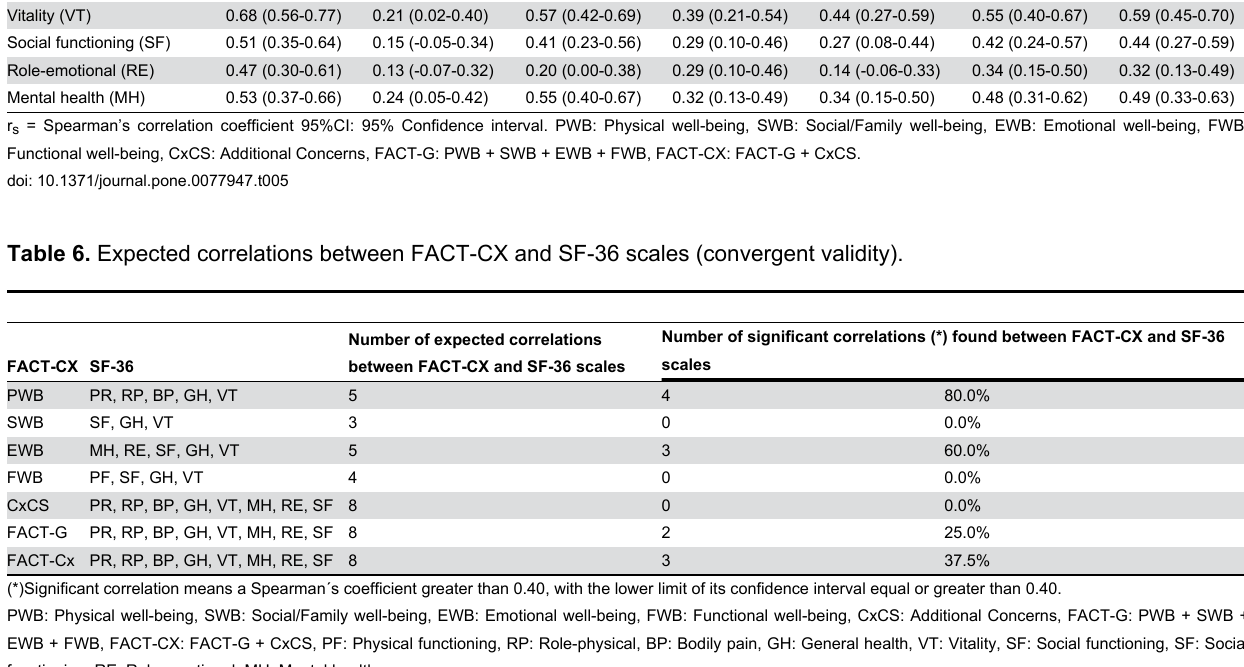
Table 5. Correlation coefficients between FACT-CX and SF-36 (convergent validity).